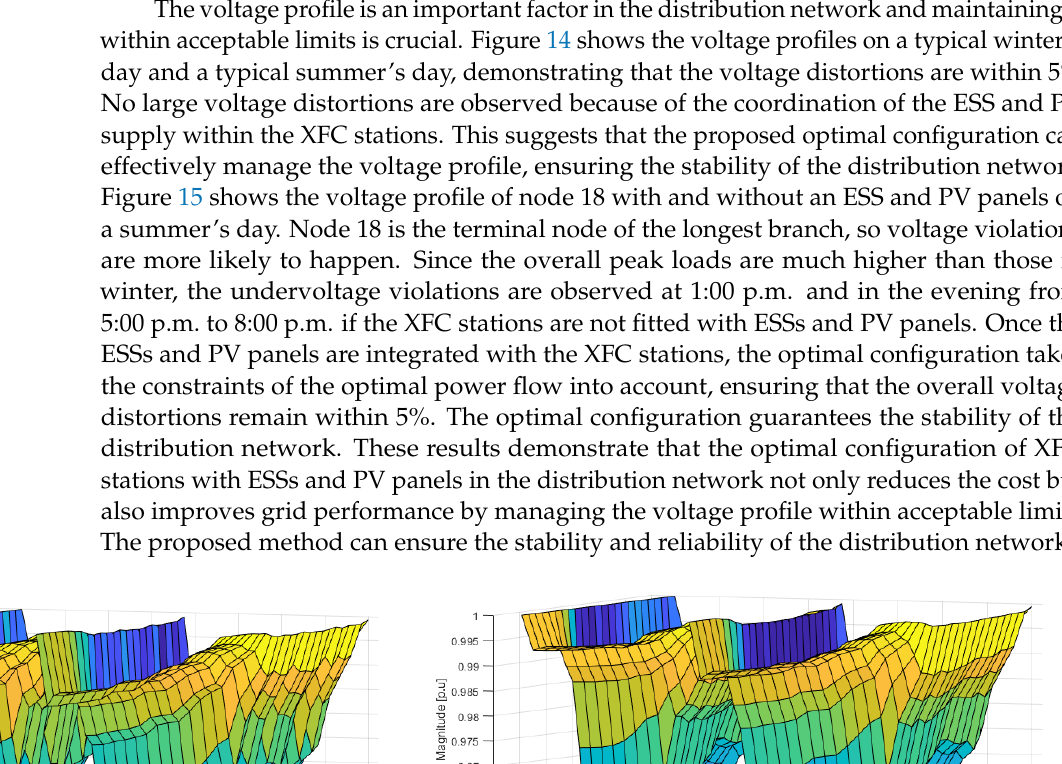
Figure 13. Imported power of XFC8 on a summer’s day.